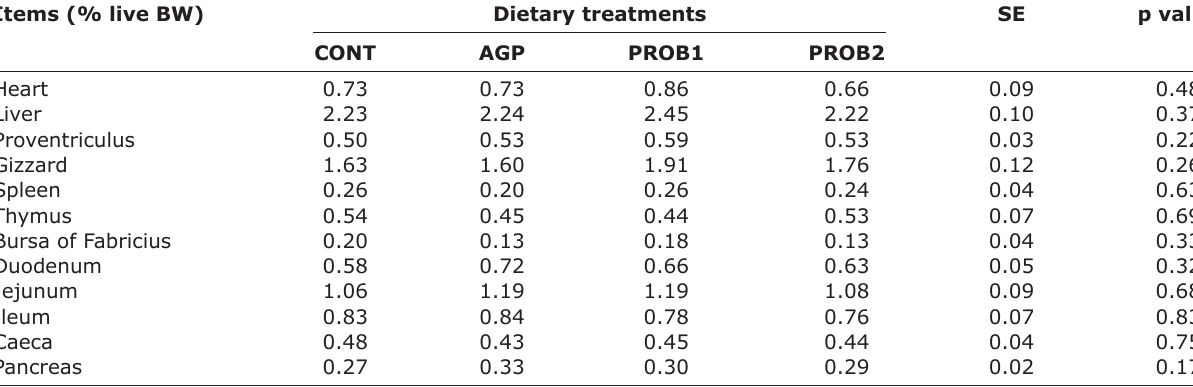
Table-3: Effect of multi-strain probiotic preparation in combination with vitamins and minerals on internal organs relative weight of the Indonesian indigenous crossbred chickens. Items (% live BW)